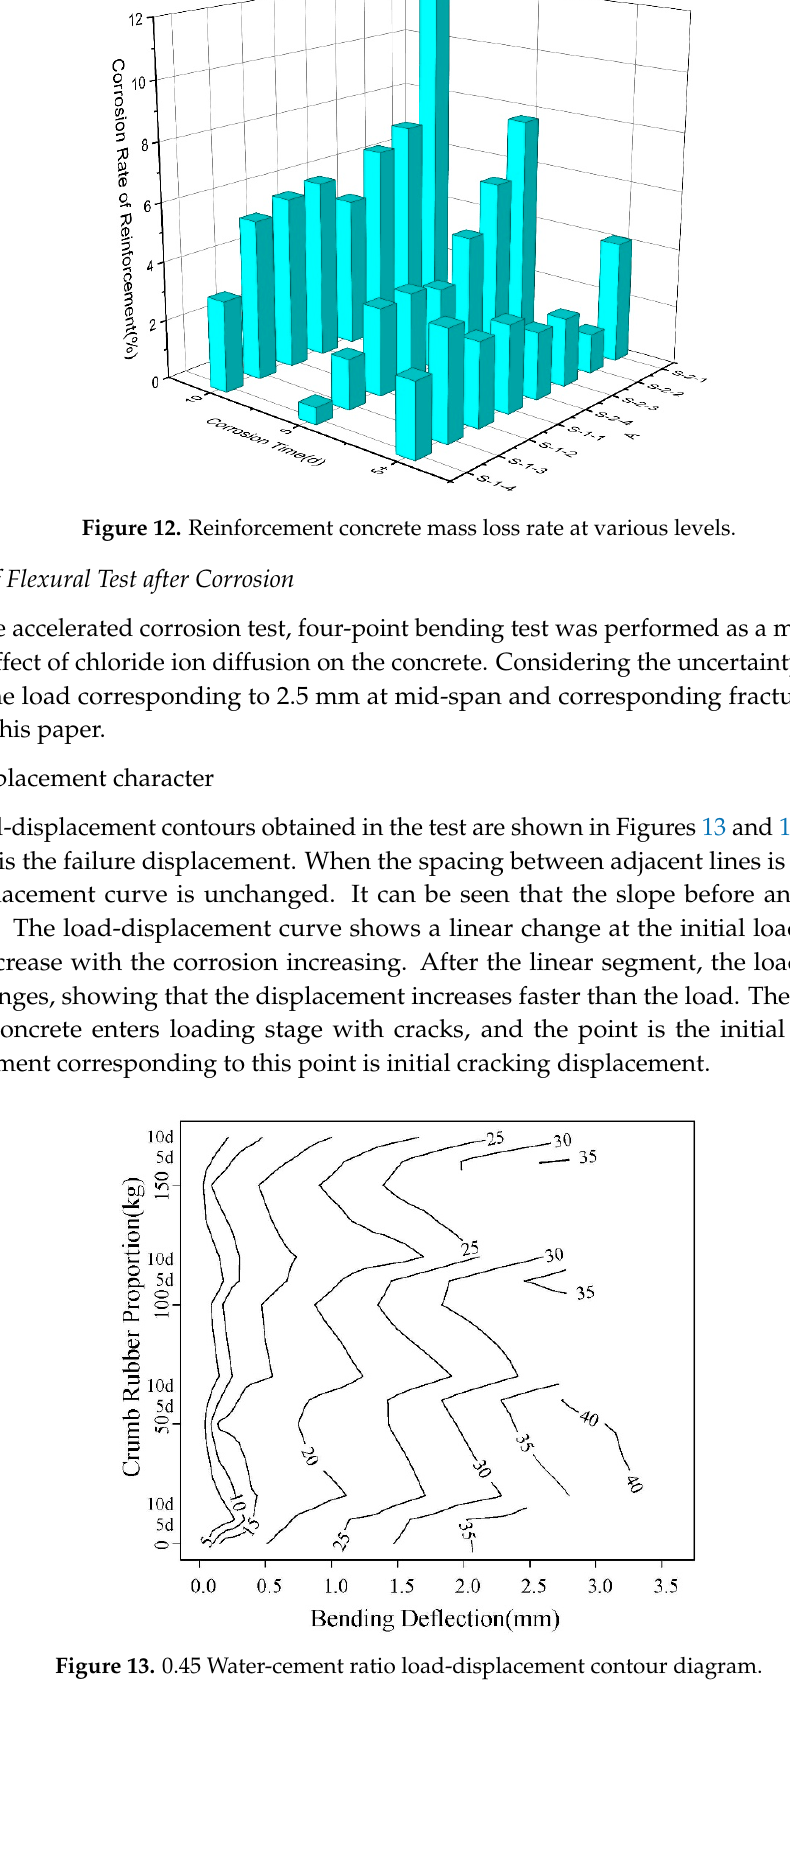
Figure 14. 0.55 water-cement ratio load-displacement contour diagram. In this paper, the load corresponding to 2.5 mm is compared. As shown in Figures 15 and 16, this load shows a decreasing trend with the increase of corrosion time. A same trend was observed for rubber content. In addition, the load of high W/C ratio is slightly larger than that of low one.